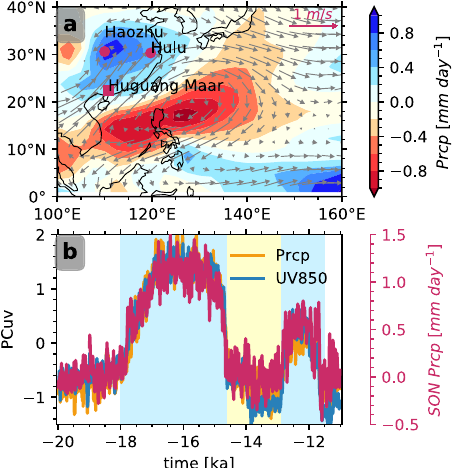
Fig. 2 Coherence in autumn rainfall and WNPAC. a Leading mode of the MCA analysis between precipitation (shading) and 850-hPa circulation (vector); b time-expansion coef fi cients of the precipitation (yellow) and circulation (blue), and autumn-precipitation anomaly time series relative to LGM (red). In b , the time-expansion coef fi cients are normalized to unit variance.